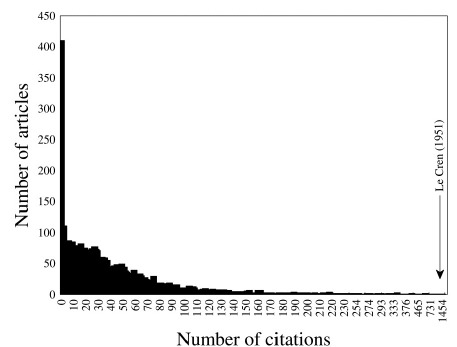
Figure 3. Histogram of the number of citations of the articles published between 1945 and 2015 in the Journal of Animal Ecology based on a search carried out in May 2016. Le Cren’s paper is highlighted.